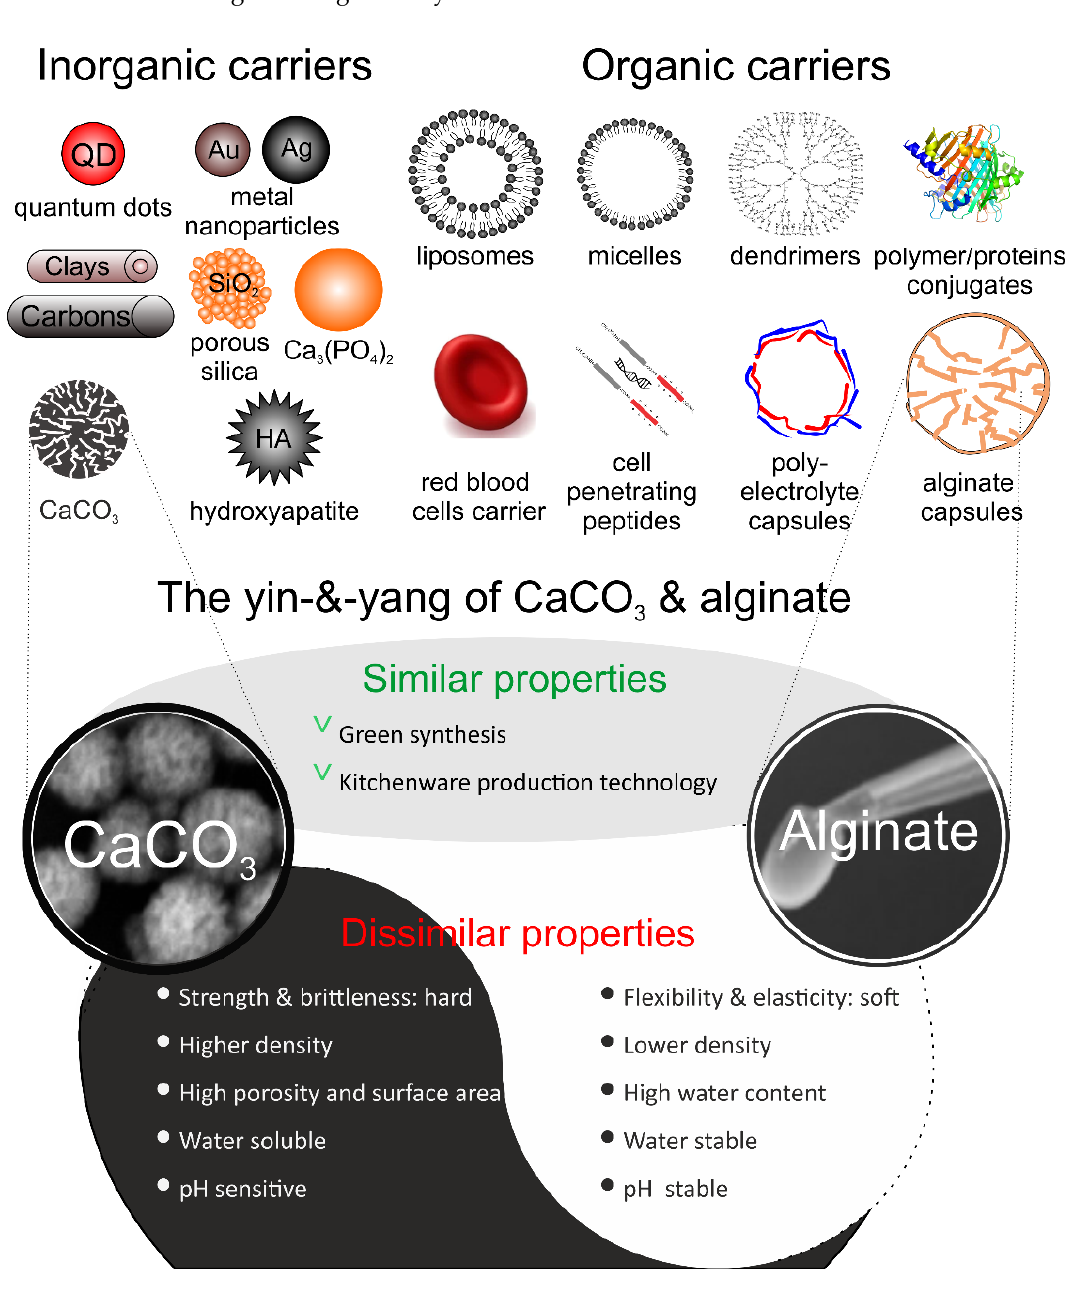
Figure 1. An overview of inorganic and organic drug delivery carriers including calcium carbonate and alginate carriers ( above ). Similarities and differences (yin-&-yang properties) between CaCO 3 and alginate and their respective attributes ( below ).